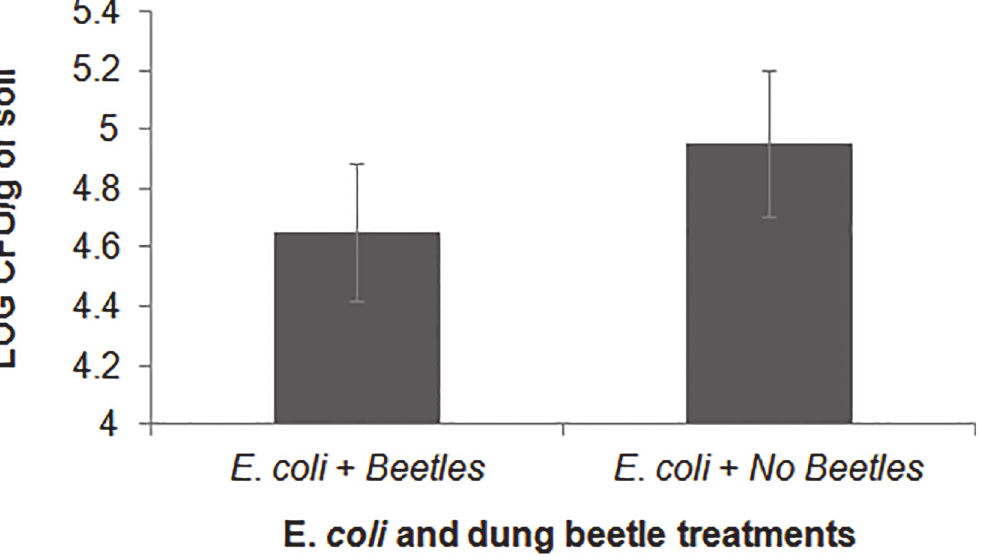
Fig 3. Laboratory experiment 2- Dung beetles affect number of E . coli colonies. Levels (log CFUs) of colorless bacterial colonies present within each treatment from lab experiment 2. Significant differences exist ((F (2,17) = 8.062, P = 0.004)) indicating dung beetles can decrease the amount of E . coli present within the system (shown with means and SE